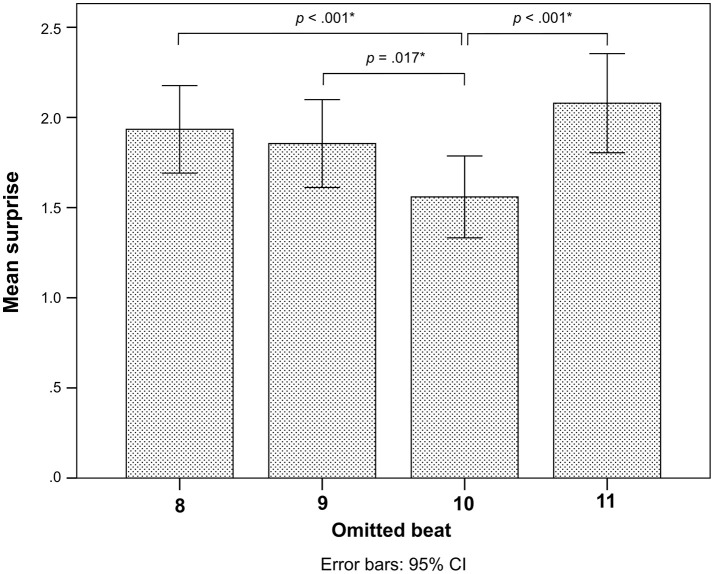
Post-hoc comparisons for surprise of each omitted beat position as rated by all participants. Error bars indicate 95% confidence intervals. The p-values are corrected for multiple comparisons with the FDR method, and the significant p-values are shown and marked by asterisks *.